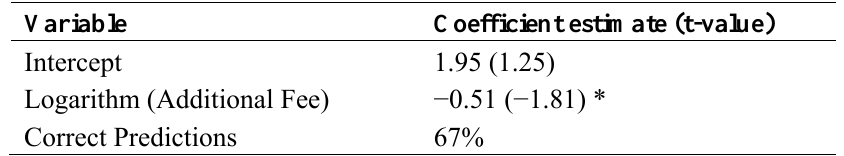
Table 6. Coefficient estimates on the willingness to accept additional